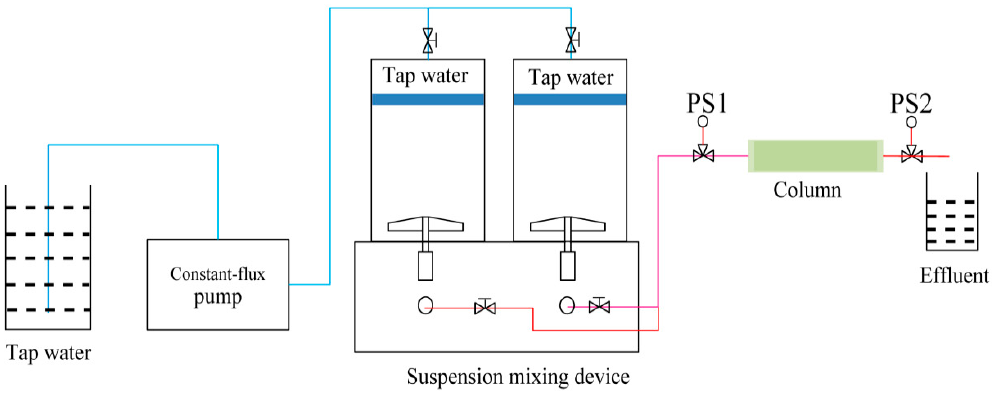
Figure 1. Schematic of column transport experiments.